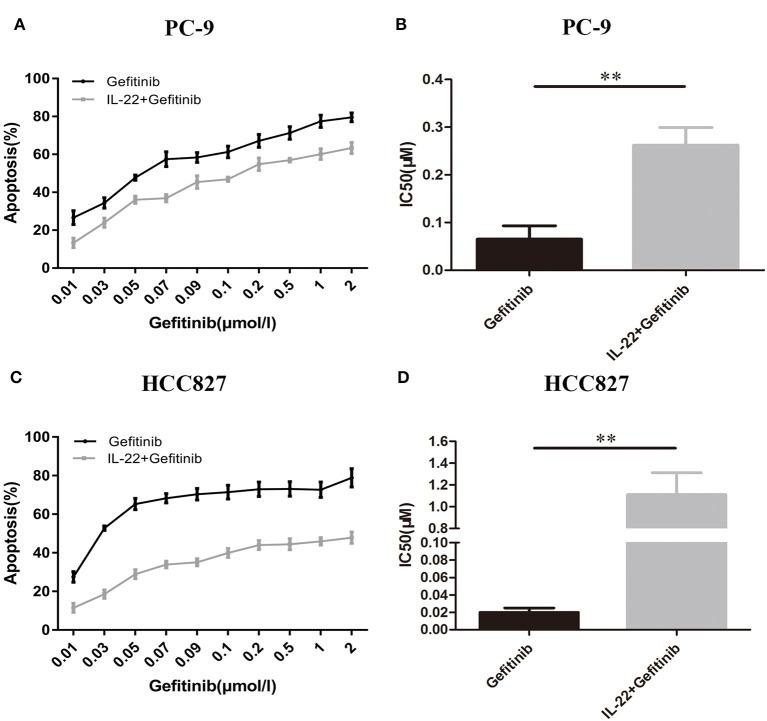
IL-22 induced resistance to gefitinib in PC9 and HCC827 cells in vitro. (A) PC-9 and (C) HCC827 cells were co-treated with gefitinib (0.01–2 μM) with or without IL-22 (50 ng/ml) for 48 h. Cell survival was measured using CCK-8 assay, and was expressed as a percentage of cell viability relative to control cells. (B) PC-9 and (D) HCC827 cells IC50 values of gefitinib were calculated for each cell. **P < 0.01 for gefitinib plus IL-22 compared with gefitinib alone. Results were presented as the means ± SEM of three independent experiments.